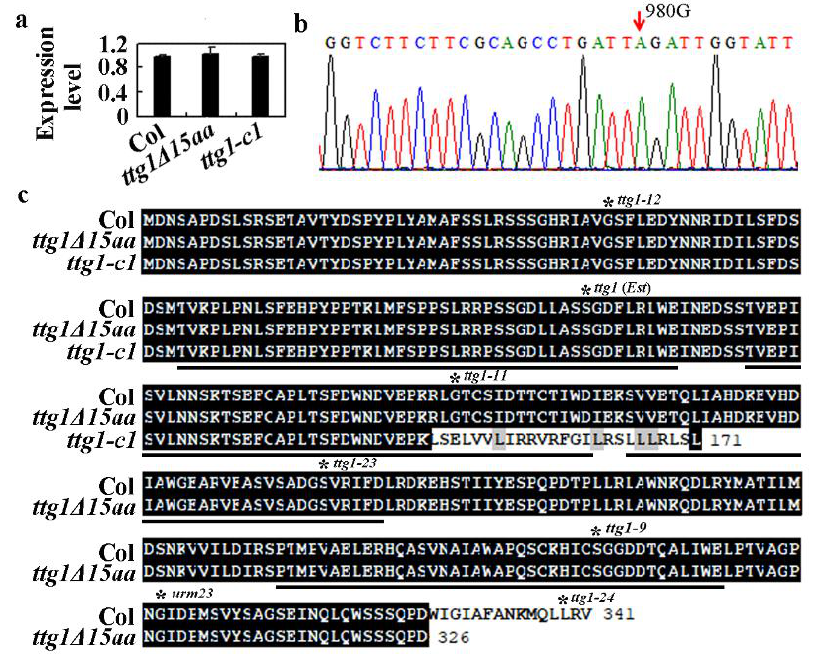
Figure 2. A single nucleotide substation in TTG1 led to premature stop in the ttg1Δ15aa mutant . ( a ) Expression of TTG1 in the Col wild type, the ttg1Δ15aa , and the ttg1-c1 mutants. RNA was isolated from 10-day-old seedlings, and qRT-PCR was used to examine the expression of TTG1 . The expression of ACT2 was used as an inner control, and the expression level of TTG1 in the Col wild type was set as 1. Data represent the mean ± SD of three replicates. ( b ) Sequence of TTG1 in the ttg1 ∆ 15aa mutant. The arrow indicates the 980G-A single-base substitution. ( c ) Amino acid alignment of TTG1 in the Col wild type, the ttg1 ∆ 15aa , and the ttg1-c1 mutants. ORFs of TTG1 in the ttg1 ∆ 15aa and the ttg1-c1 mutants were identified by using DNAMAN, and the predicted full-length amino acid sequences were used for alignment with the full-length amino acid sequence of TTG1 in the Col wild type. The numbers at the C-terminal indicate the numbers of total amino acids of TTG1 in the Col wild type, the ttg1 ∆ 15aa , and the ttg1-c1 mutants. Solid underlines indicate the WD40 domains. Stars indicate the amino acids that were substituted in the corresponding mutants as summarized previously [2].